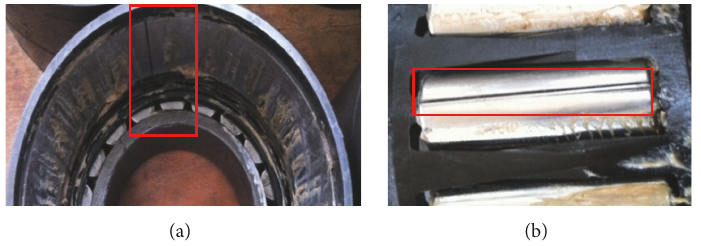
Figure 9: Photo of the artificial faults on the tapered roller and outer race.